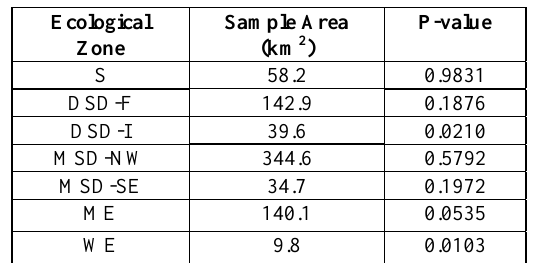
Figure 6. A Sample View of the Acquired LiDAR Data